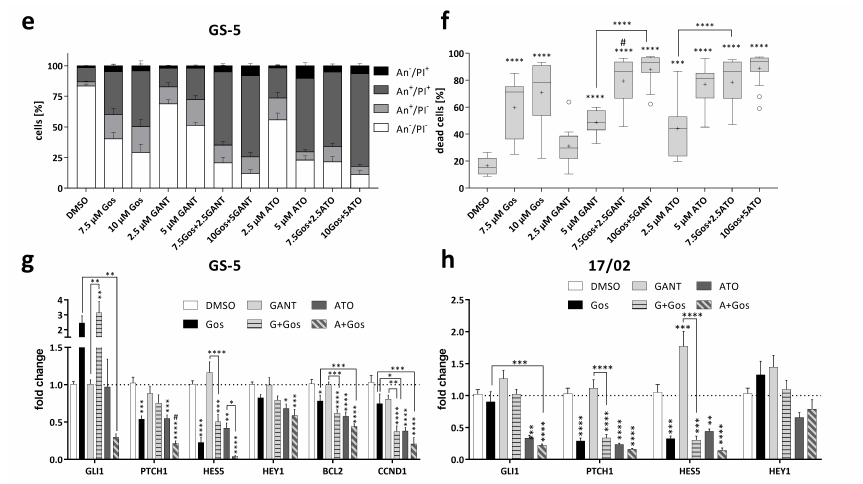
Figure 1. Synergistic inhibition of viability and induction of cell death of GS-5 and 17/02 GSCs via inhibition of Hh and Notch signaling. ( a ) Morphological appearance of GS-5 24 h after treatment with solvent (DMSO), 5 µ M GANT, 5 µ M ATO or 7.5 µ M Gos alone or in combination. Note that after ATO (upper right) single treatment more single cells (black arrows) and disintegrating spheres (white arrows) can be detected which is further enhanced by ATO/Gos combination treatment and also after GANT/Gos; scale bar: 100 µ m. ( b , c , left side) Box-Plots (Tukey) of MTT assay of GS-5 after treatment for 24 h with increasing concentrations of ( b ) ATO or ( c ) GANT in combination with Gos. ( b , c , right side) The CI was calculated from the data obtained according to Chou et al. [21] using the non-constant ratio setting (CI > 1: antagonism; CI = 1: additive; CI < 1: synergism). The CI value is given as a single value calculated from the summary of all experiments. ( d ) Representative Dot-Plots of GS-5 after treatment for 24 h with solvent (DMSO), 2.5 µ M GANT, 2.5 µ M ATO or 7.5 µ M Gos alone or in combination. ( e ) Stacked bar chart of GS-5 after treatment for 24 h with the drugs and concentrations as indicated. ( f ) Box-Plots (Tukey) of the percentages of dead cells (100%—An-/PI-) after treatment. The lines in the Box-Plots represents the median, the plus-symbol the mean. ( g , h ) Bar graph of Taqman-based gene expression analysis of ( g ) GS-5 and ( h ) 17/02 after treatment with 5 µ M Gos, 2.5 µ M GANT or ATO or the combination of GANT or ATO with Gos (G + Gos; A + Gos). The MTT assays were performed